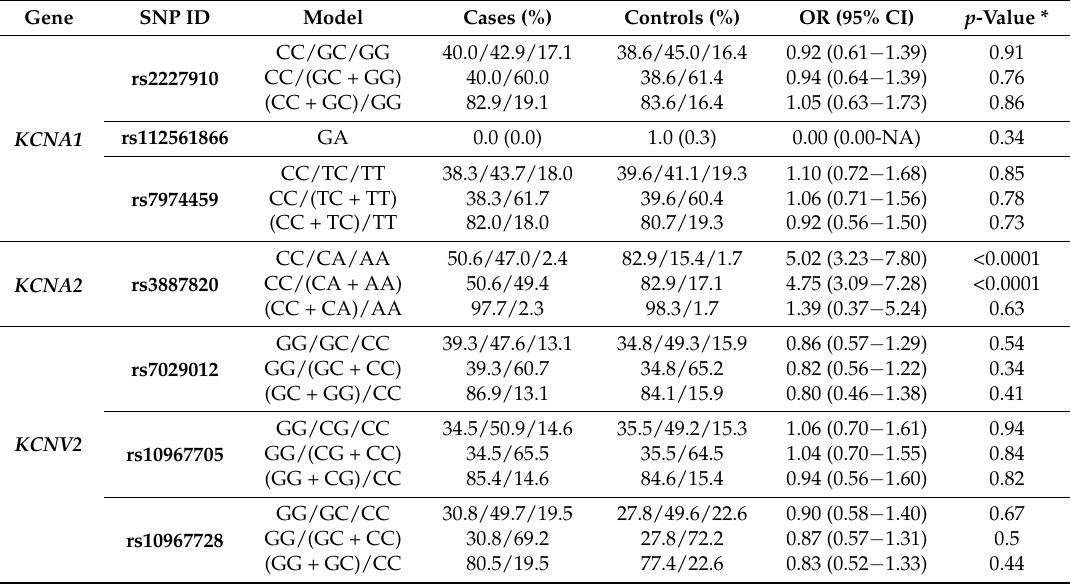
Table 2. The distributions of potassium channel related genes SNPs in the 172 generalized epileptic patients and 299 healthy controls.